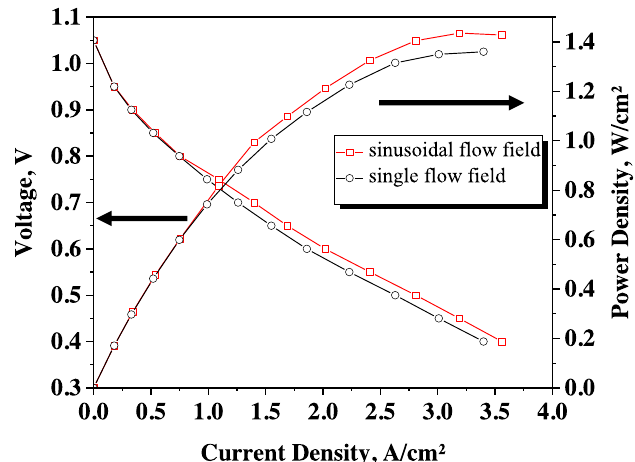
Fig. 8. The polarization curve ( J − V ) and power density curve for two different fl ow designs.